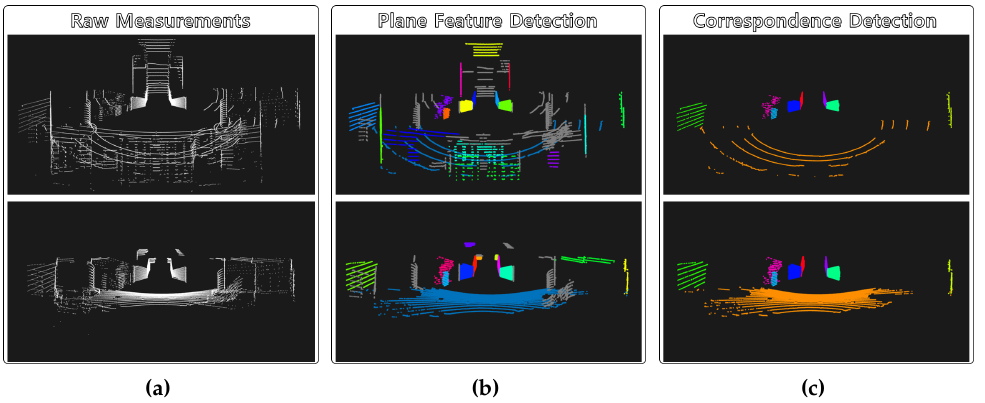
Figure 5. Process of plane correspondence detection. Each row corresponds to the reference and source LiDAR sensors. Each column corresponds to ( a ) raw measurements, ( b ) plane object detection, and ( c ) correspondence detection.